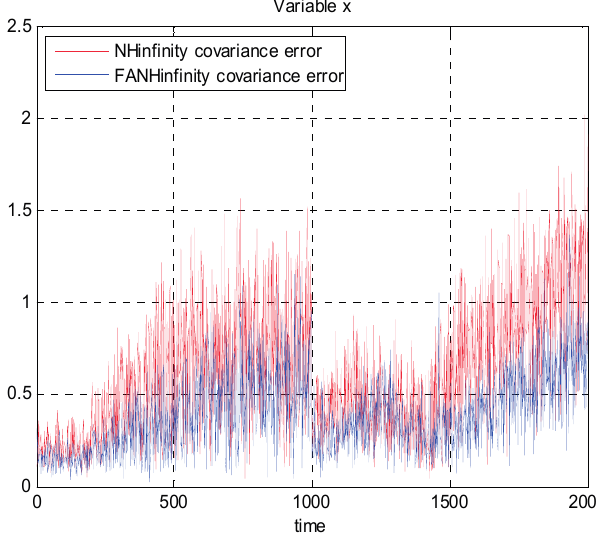
Figure 17. Error covariance in x -axes using the true